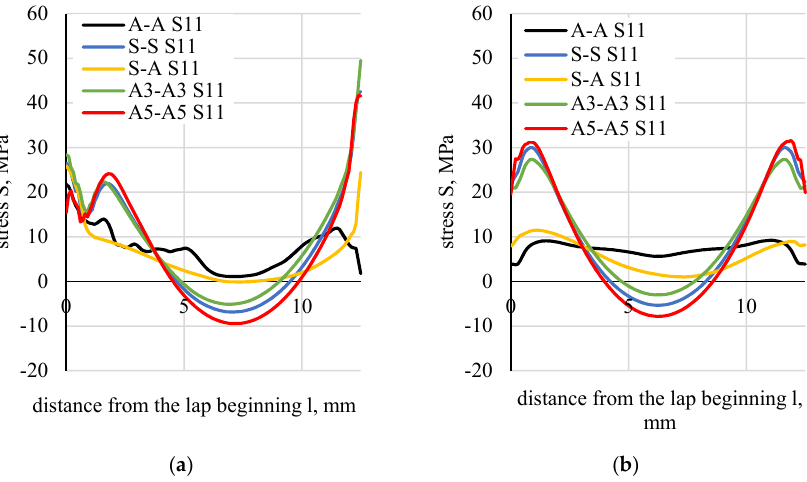
Figure 24. Distributions of normal stresses (S11) parallel to the direction of tension: ( a ) in the element–adhesive layer, ( b ) half length of the adhesive thickness.